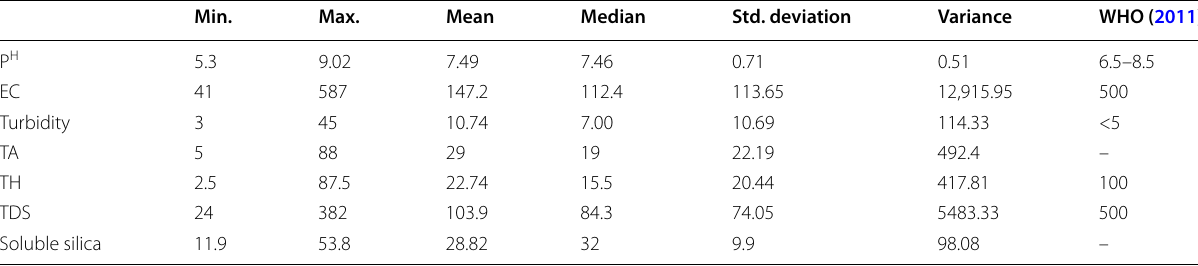
Table 3 Statistical analysis of physicochemical parameters in water around the study area